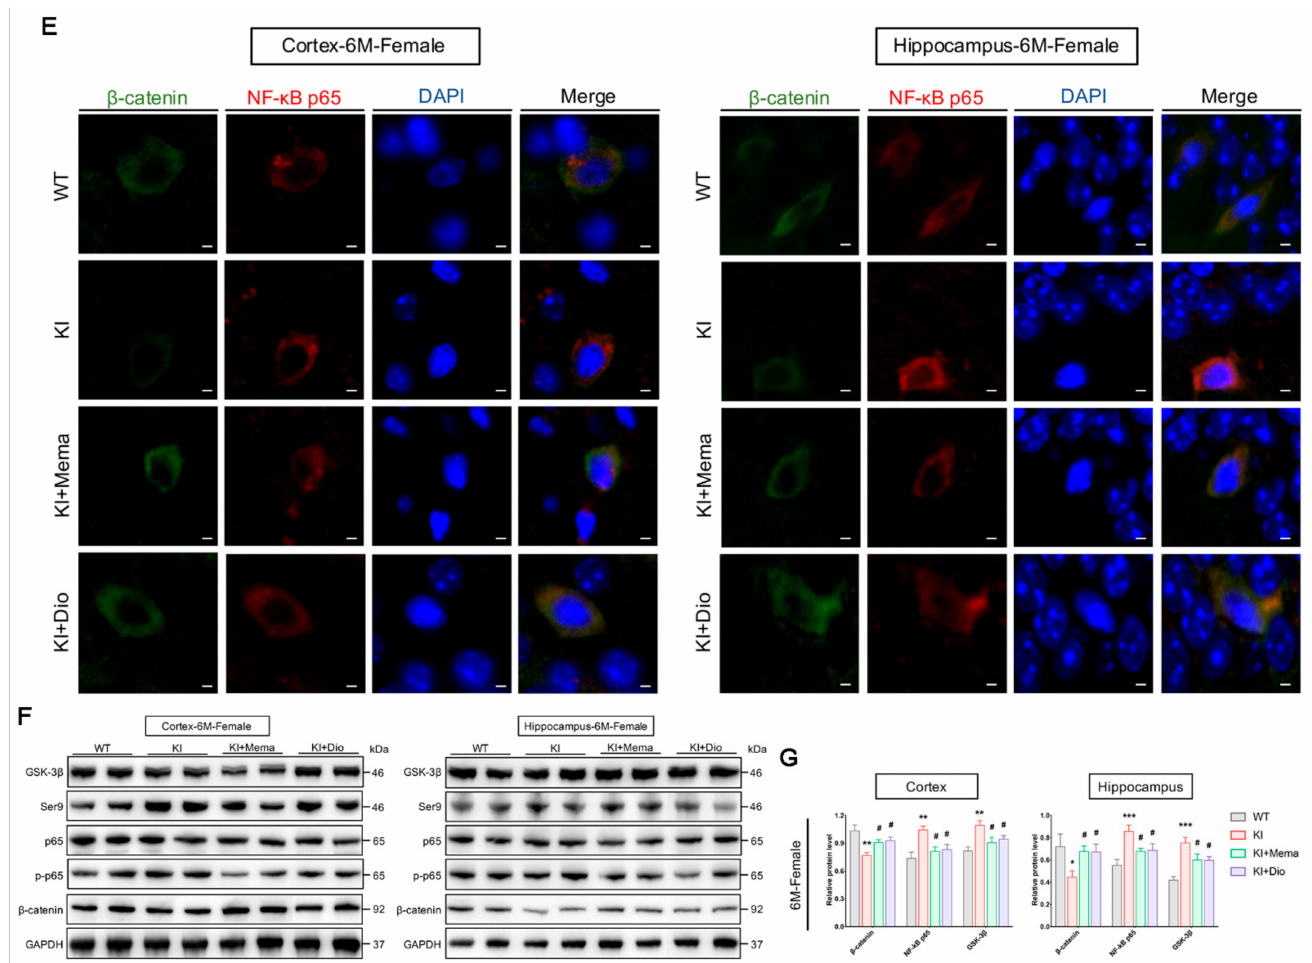
Figure 5. Dio affects proinflammatory cytokines and brain NF- κ B/ β -catenin signaling in young App NL-G-F mice. ( A ) The serum IL-1 β and TNF- α levels in 3- and 6-month-old male and female WT and App NL-G-F . ( B , E ) Merged immunofluorescence images of NF- κ B, β -catenin, and DAPI co-localized in the cortex and hippocampal region in 6-month-old male and female WT and App NL-G-F mice. Scale bar: 10 µ m; ( C , D , F , G ) Western blot and quantification of GSK-3 β , p-GSK-3 β (Ser9), NF- κ B p6, 5p-NF- κ B p65, and β -catenin protein expression in the cortex and hippocampus in 6-month-old male and female WT and App NL-G-F mice. Data are expressed as mean ± SEM. n = 6 mice/group. * p < 0.05 compared with WT; ** p < 0.01 compared with WT; *** p < 0.001 compared with WT. # p < 0.05 compared with App NL-G-F